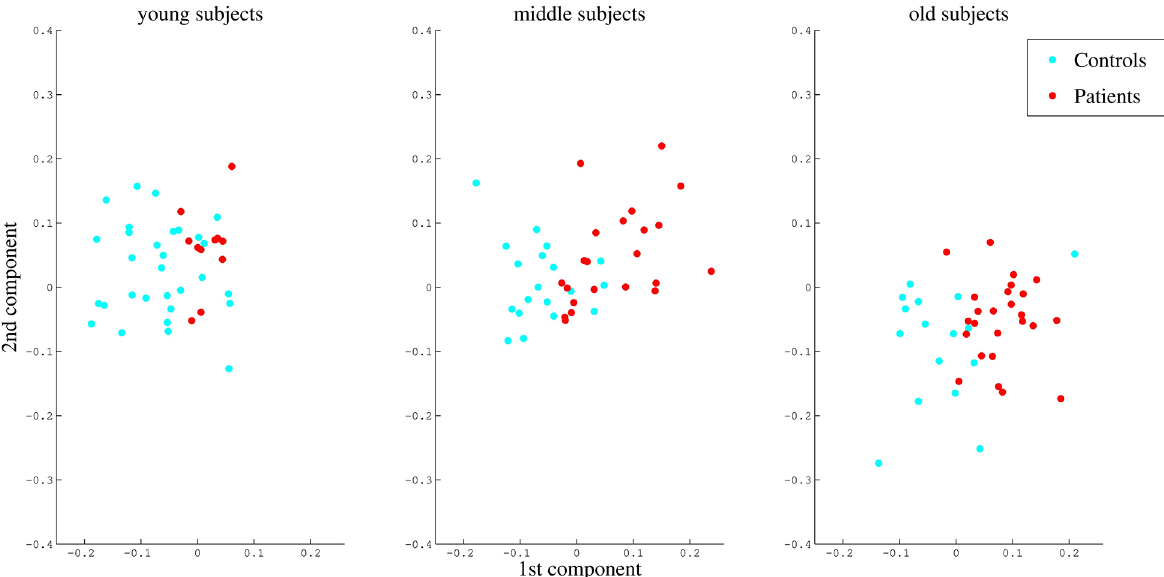
Fig 8. Scatterplot of subjects separatedon the basis of the two latent components generated from KPLS-Poly(2) for young, middle, and old subjects. Old subjects have significantly lower values in the second component ( p < 10 − 5 by Wilcoxon Rank-Sum